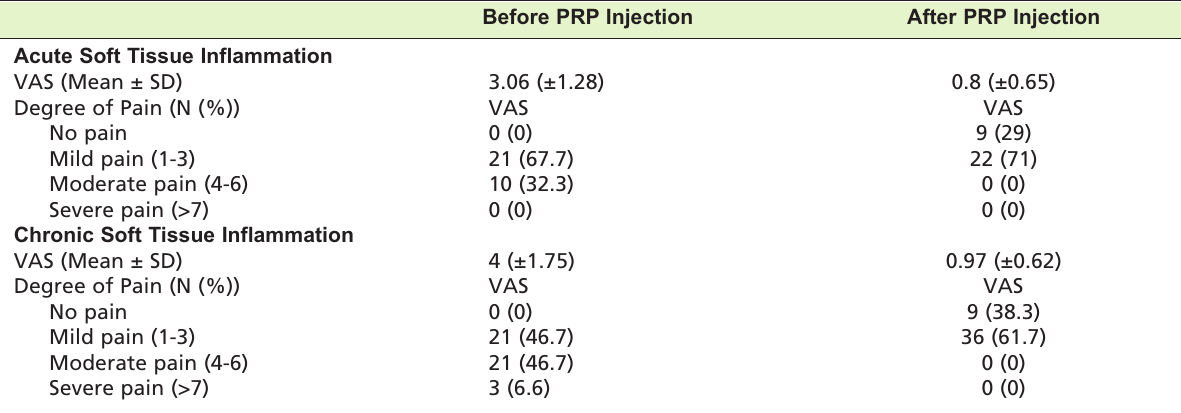
VAS evaluation before and after PRP injection Table II: